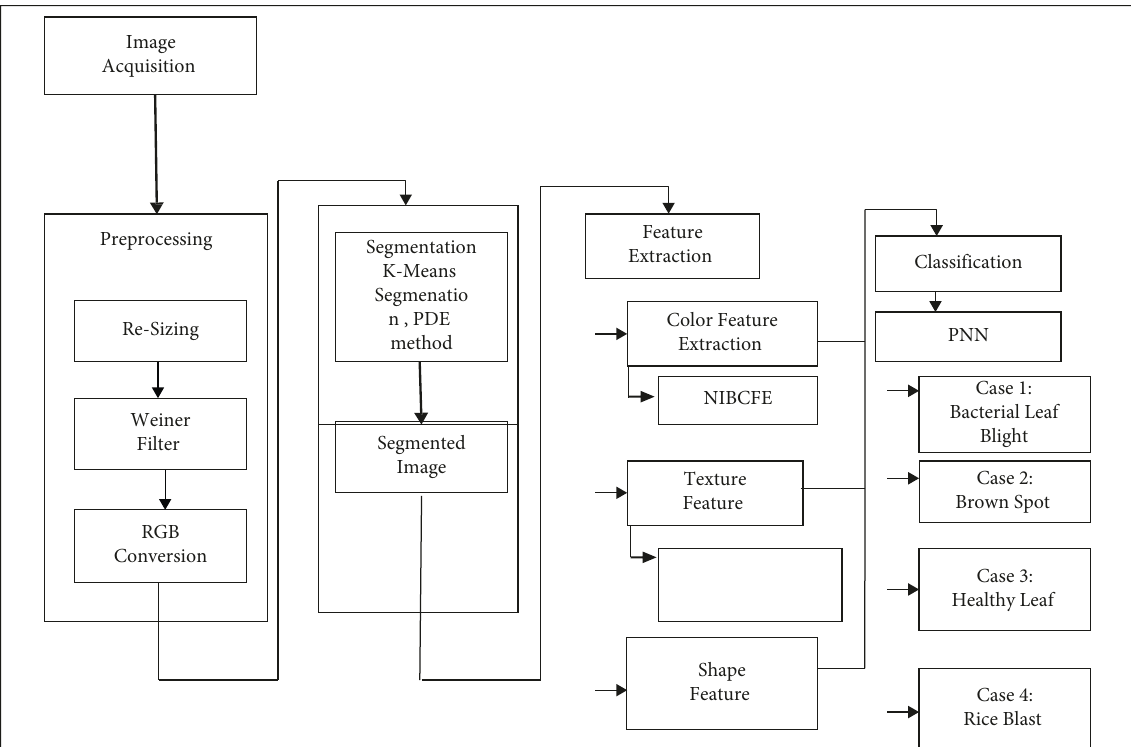
Figure 2: Architecture of proposed methodology to predict and classify disease in rice plant leaf image acquisition.